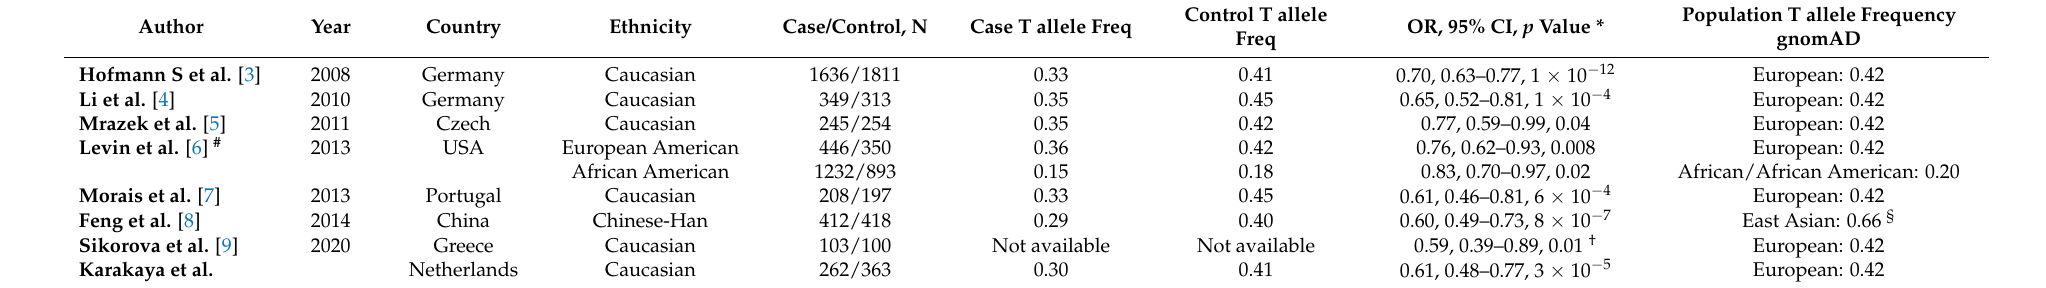
Table 4. Previous and present ANXA11 rs1049550 association studies with